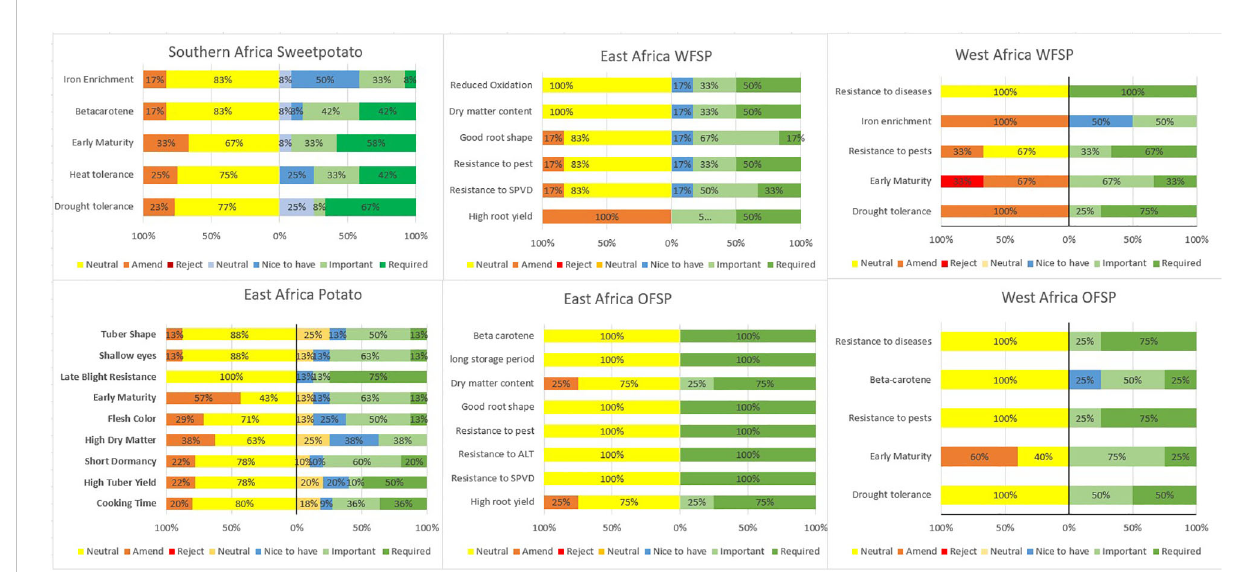
FIGURE 4 Cross-functional workshop results on gender impact scores of the traits in different potato and sweetpotato